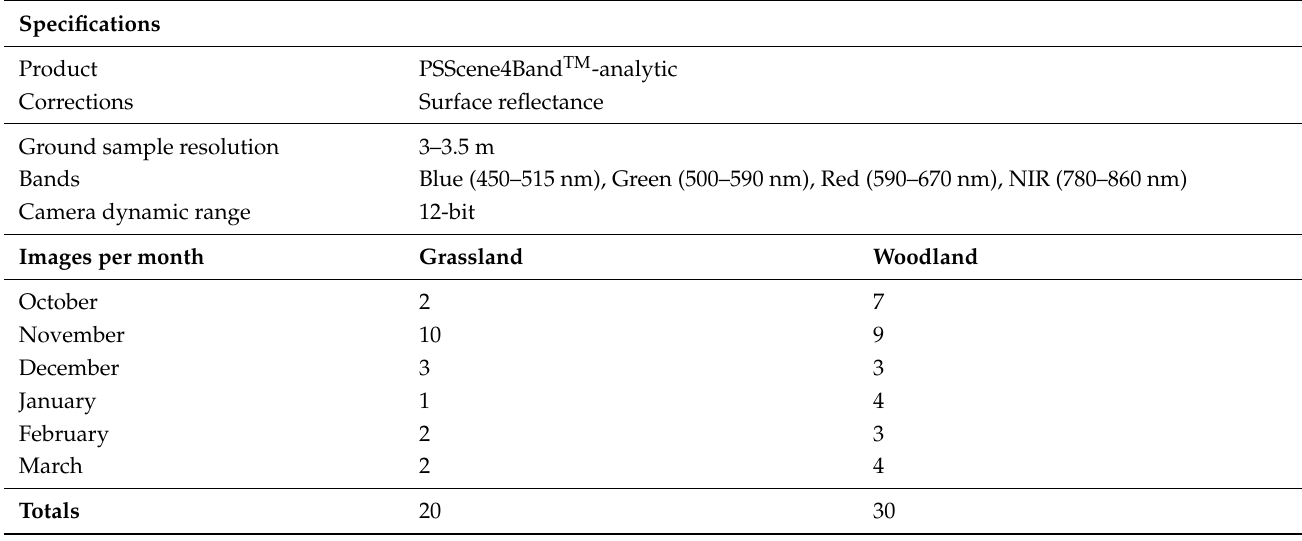
Table 3. Planet Dove satellite image data parameters and collection